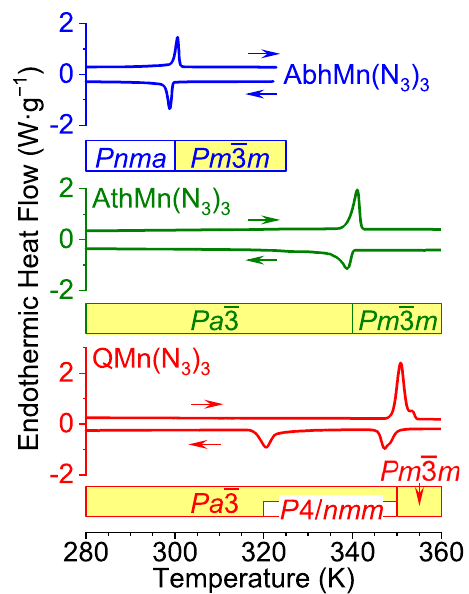
Fig. 2 Cyclic DSC curves and phase transition diagrams for AbhMn(N 3 ) 3 (blue), AthMn(N 3 ) 3 (green), and QMn(N 3 ) 3 (red) between 280 and 360K. No phase transitions were found between 100 and 280K for these